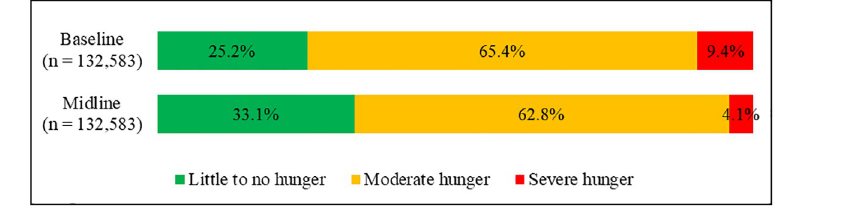
Fig 3. Caregivers’ level of household hunger at baseline and midline (n = 132,583).